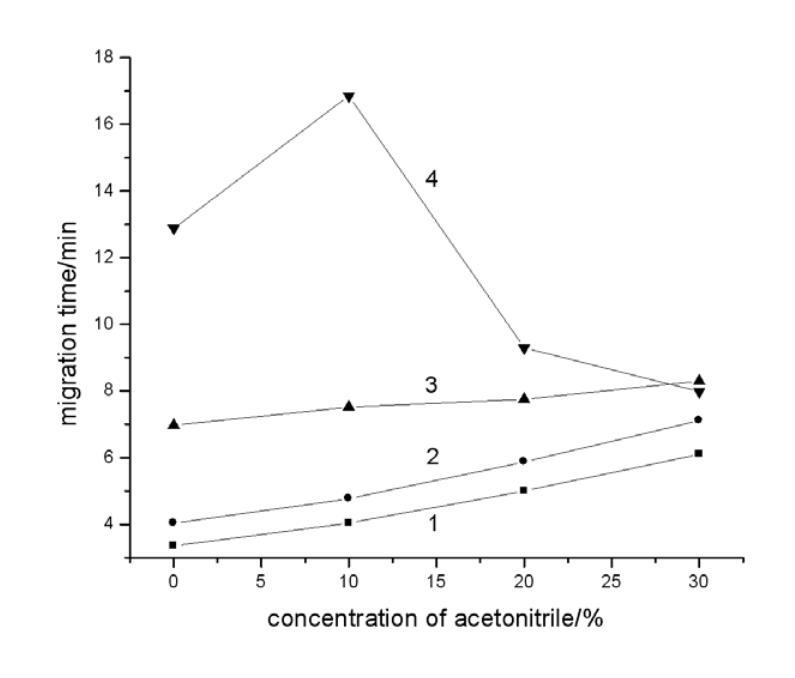
Fig. 2 Effect of acetonitrile concentration on the migration time: 1 = EOF marker; 2 = paeoniforin; 3 = paeonol; 4 = censenoside Rg 1 . Analytical conditions: 20 mM borax, 30 mM SDS, pH 9.30, applied voltage 20 kV, sample time 5 s, detection UV 203